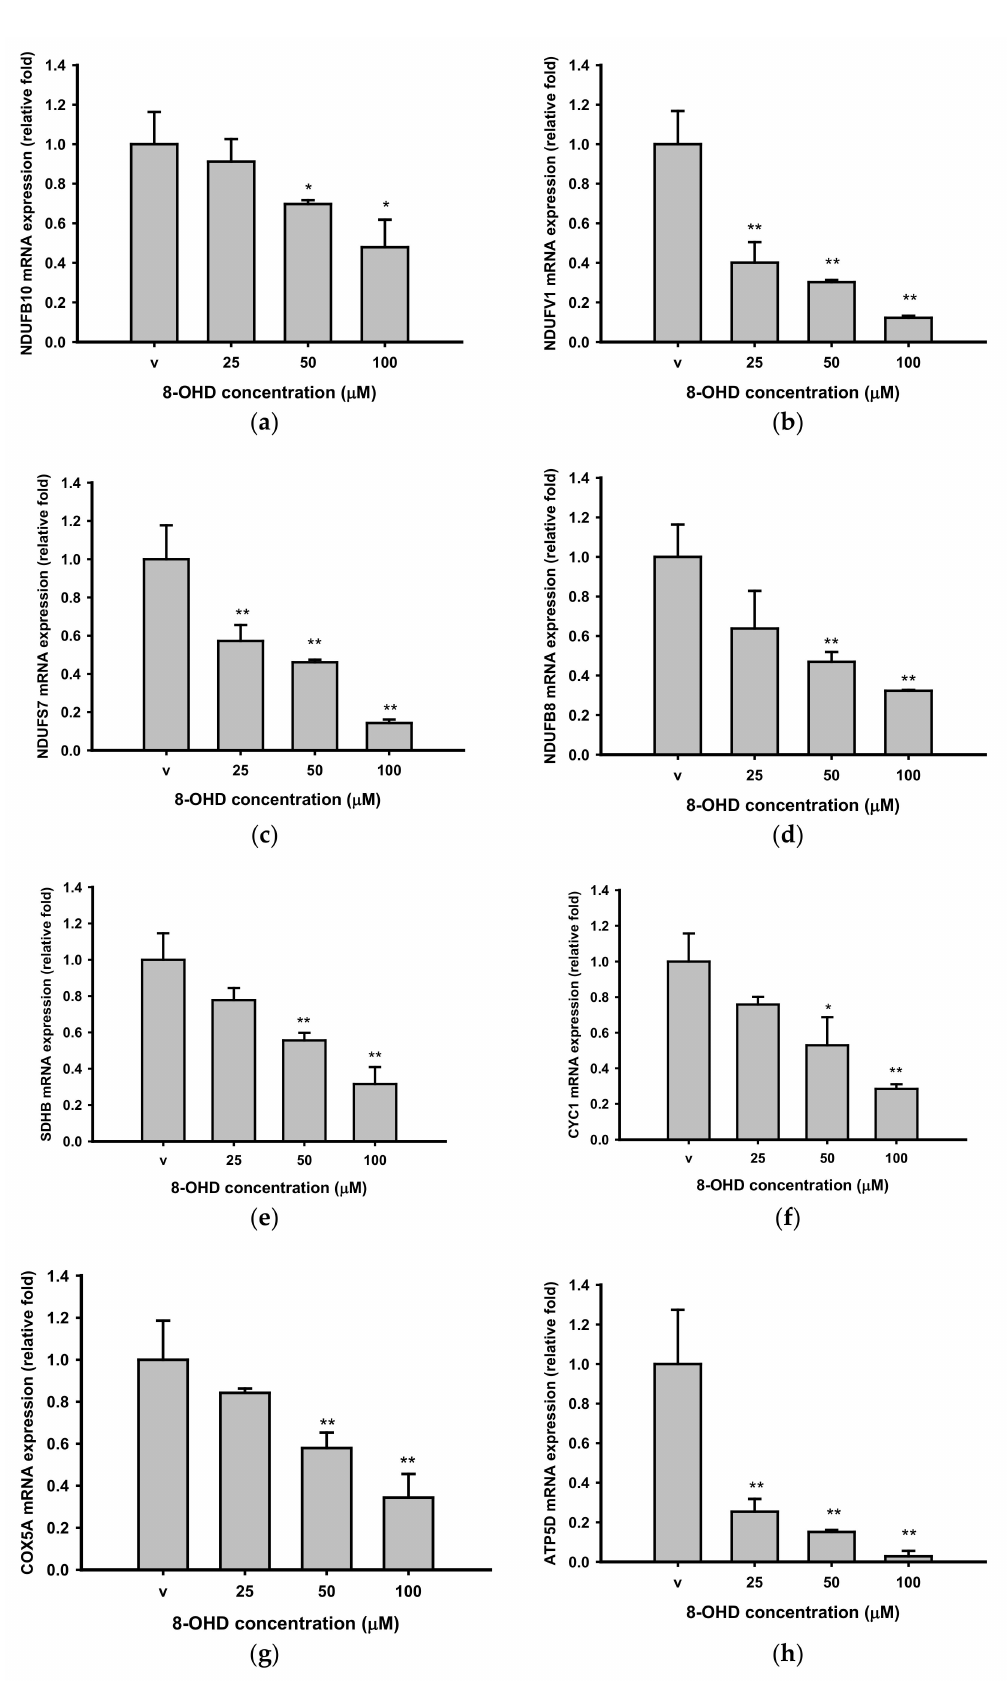
Figure 7. Reconfirmation of downregulation of oxidative phosphorylation genes by RT-qPCR. * p < 0.05 and ** p < 0.01 indicate significant differences compared to vehicle-treated